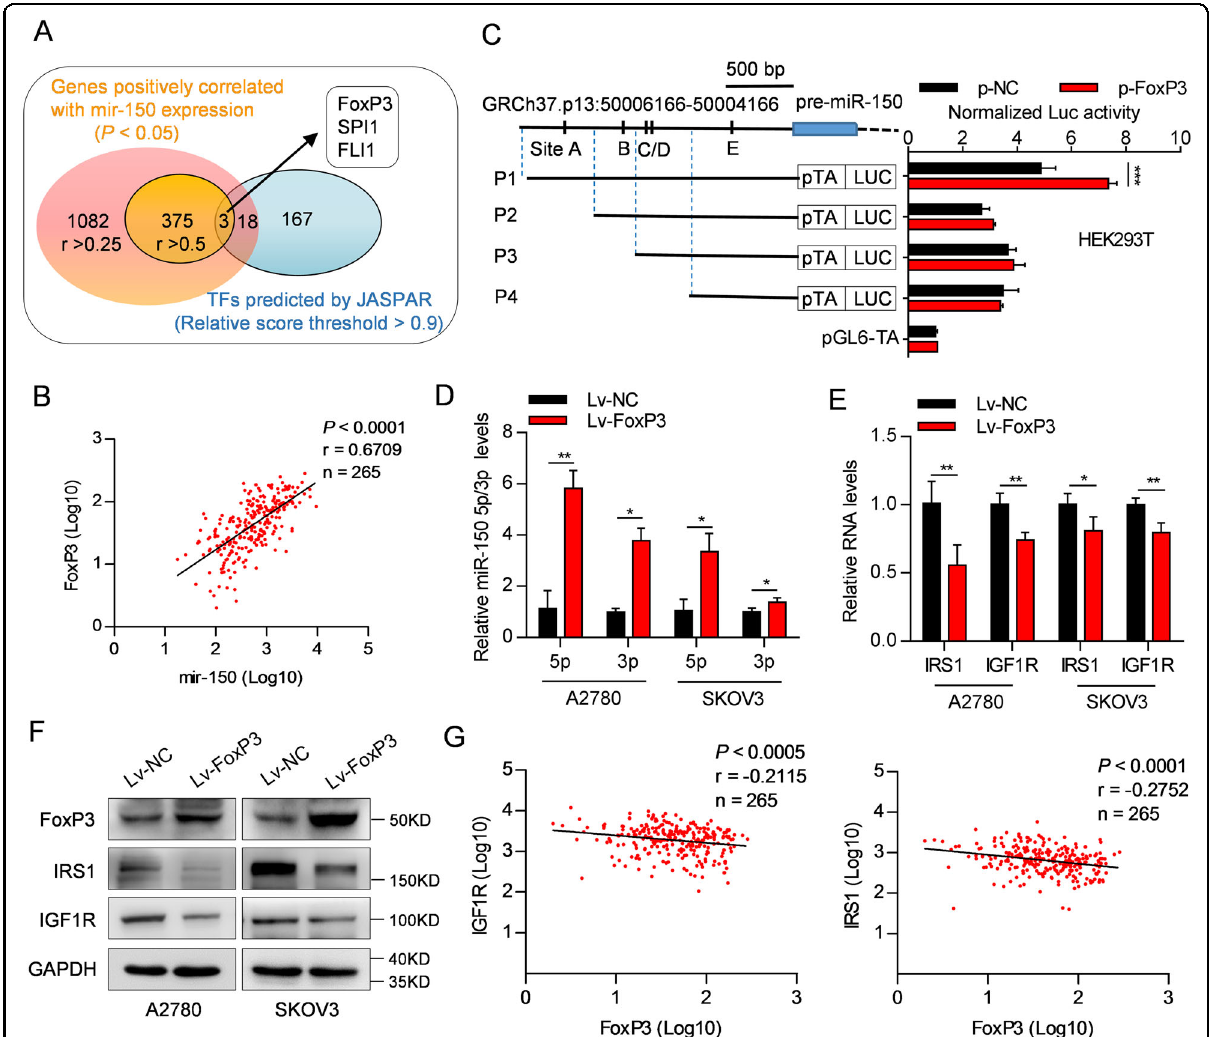
Fig. 6 miR-150-IGF1R/IRS1 axis is a downstream target of FoxP3. A Venn diagram depicting the number of predicted transcription factors (blue) in 2-kb region upstream of miR-150 using the JASPAR database (relative score threshold >0.9) and the number of protein-coding genes positively correlated with miR-150 (orange) ( r > 0.25 or >0.5, P < 0.05) in 265 OC tissues from TCGA. B Correlation between FoxP3 and mir-150 expression in 265 OC tissues from TCGA. C Diagram of the 2-kb region upstream of mir-150 promoter. The predicted FoxP3-binding sites (named A, B, C, D and E), and the DNA fragments incorporated into luciferase reporter constructs (named P1 – P4) were indicated. Luciferase reporter assays with the corresponding reporter constructs in HEK293T cells were shown. D The relative levels of miR-150-5p and miR-150-3p in Lv-FoxP3-OC cells were determined by real- time RT-PCR. E , F Relative mRNA ( E ) and protein ( F ) levels of IRS1 and IGF1R in Lv-FoxP3-OC cells were measured by real-time RT-PCR and western blotting. G Correlation between FoxP3 and IRS1 or IGF1R expression in 265 OC tissues from TCGA. The data are presented as the mean ± s.d. * P < 0.05, ** P < 0.01, *** P < 0.001 by Student ’ s t